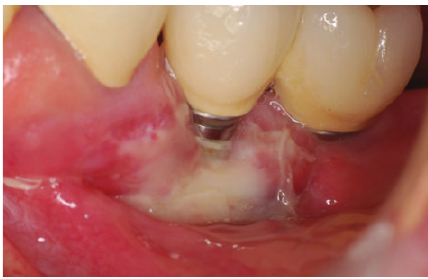
Figure 18: Postoperative aspect 7 days after surgery.